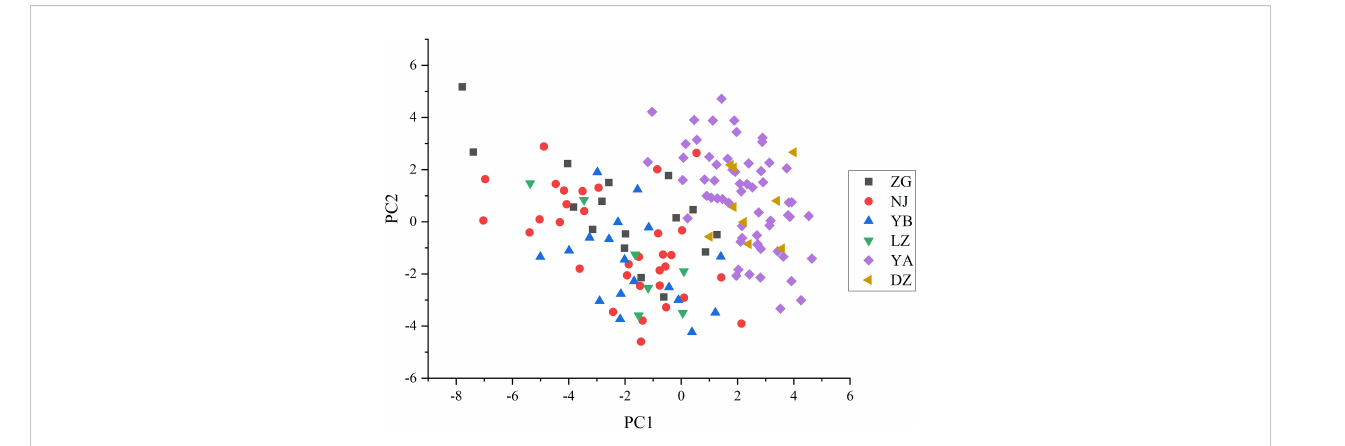
FIGURE 9 The principal component analysis of the 143 C . oleifera germplasm